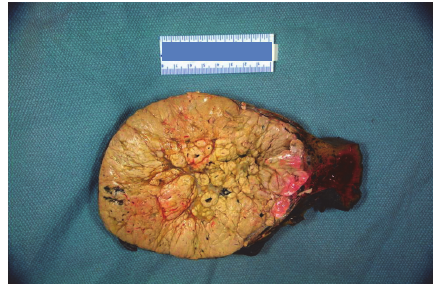
Figure 1: Resected hepatocellular carcinoma.